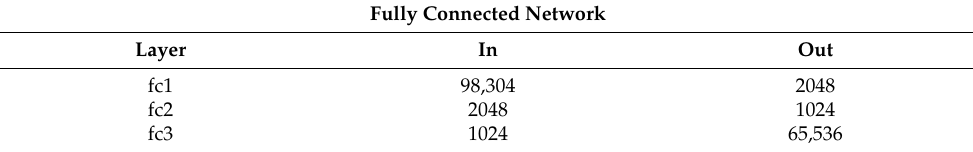
Table 2. Fully connected layer.